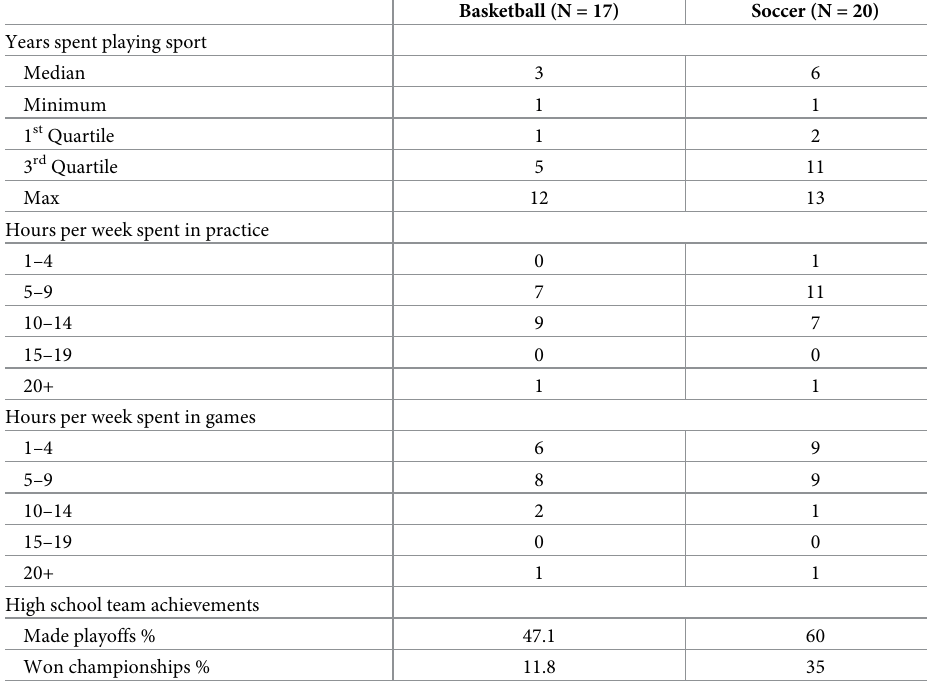
Table 2. Sports participation duration and